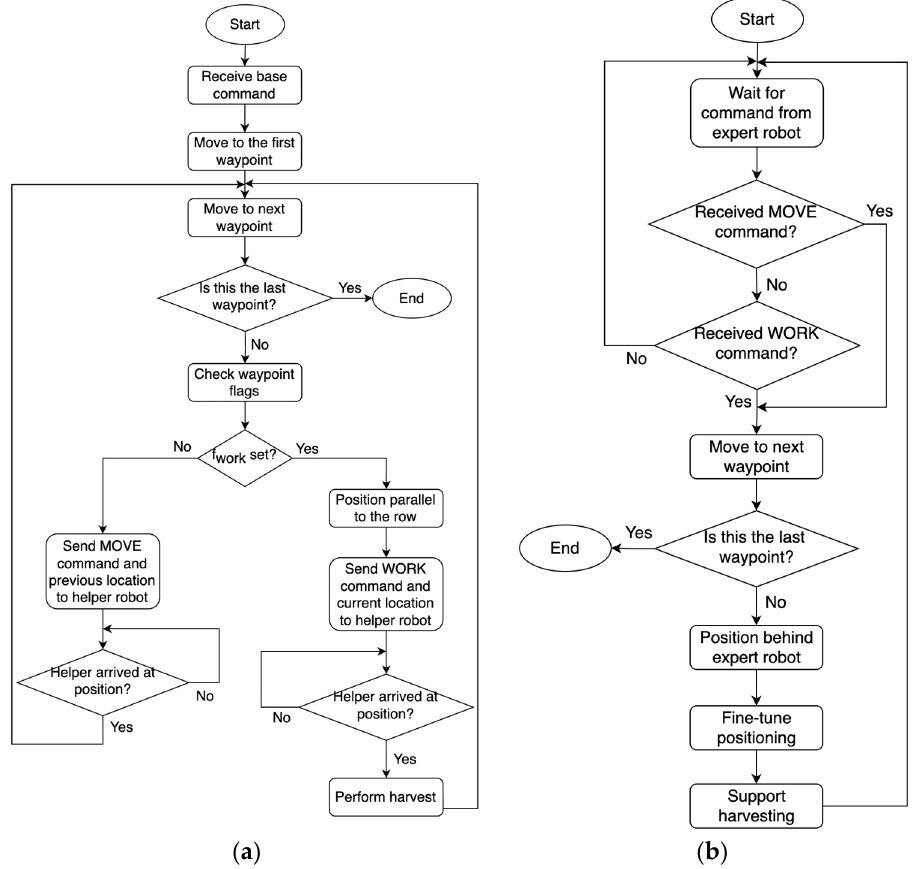
Figure 6. Coordinated navigation algorithms for ( a ) the expert robot and ( b ) the helper robot. Initially, the expert robot proceeds to the first waypoint it has received from the base station. When the expert robot arrives at the next waypoint, it checks the additional f work flag that accompanies the coordinates of the waypoint. If the f work flag is not set, then the expert robot proceeds to the next waypoint and sends its previous location to the helper robot. Upon receipt of this message, the helper robot moves to the transmitted